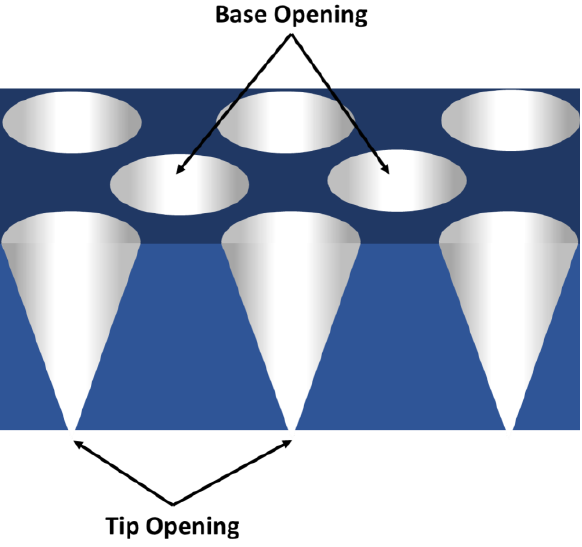
Figure 1. Schematic illustration of a membrane containing conical pores. Dimensions are not drawn to scale.